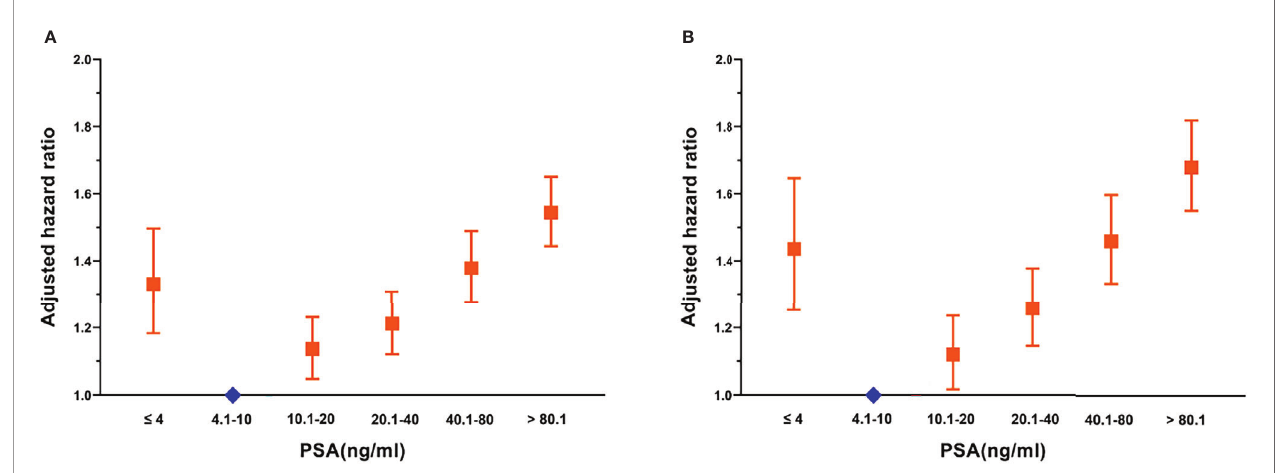
FIGURE 1 | Adjusted hazard ratios with 95% con fi dence intervals for the association between PSA and (A) overall survival and (B) cancer-speci fi c survival.